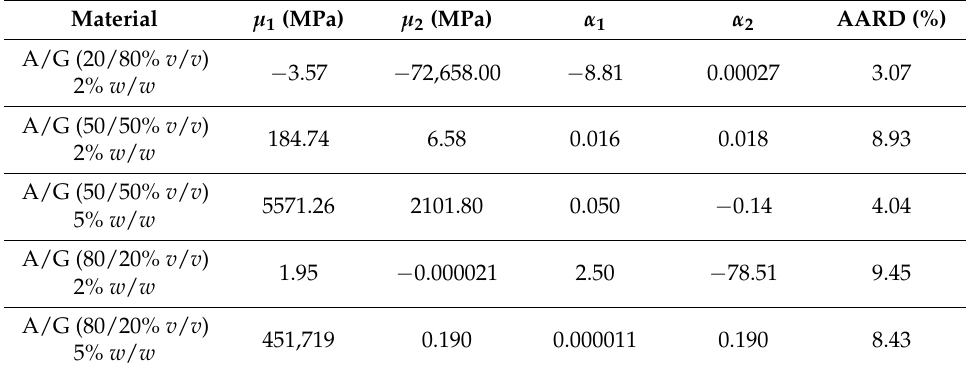
Table 2. Parameters and deviations for the Ogden model.